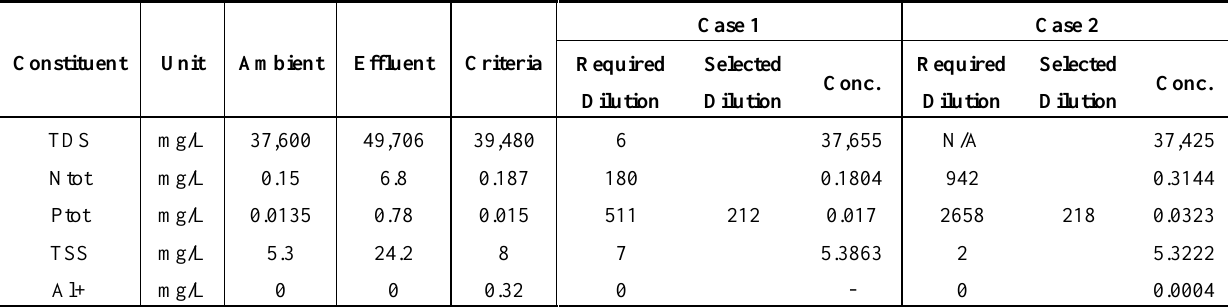
Table 3. Effluent constituent concentration at the end of mixing